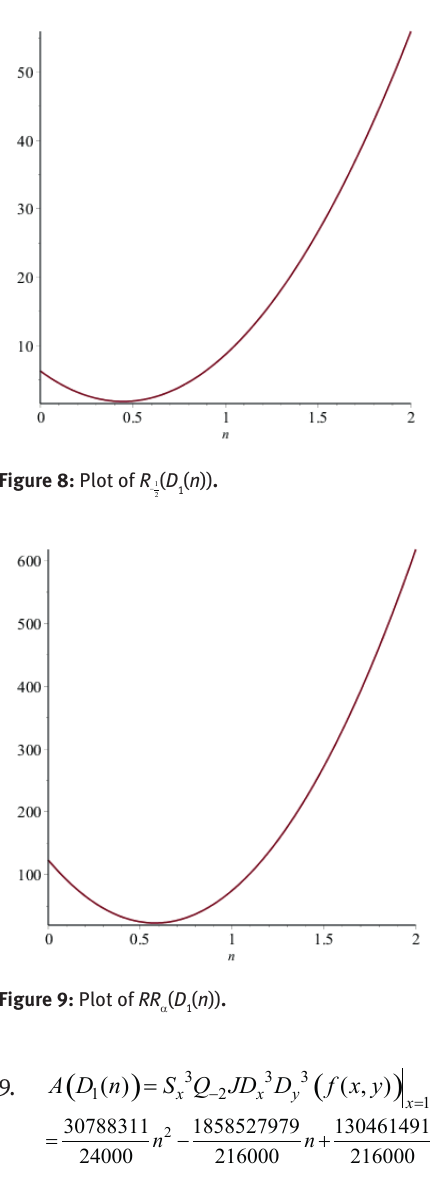
Figure 9: Plot of RR a ( D